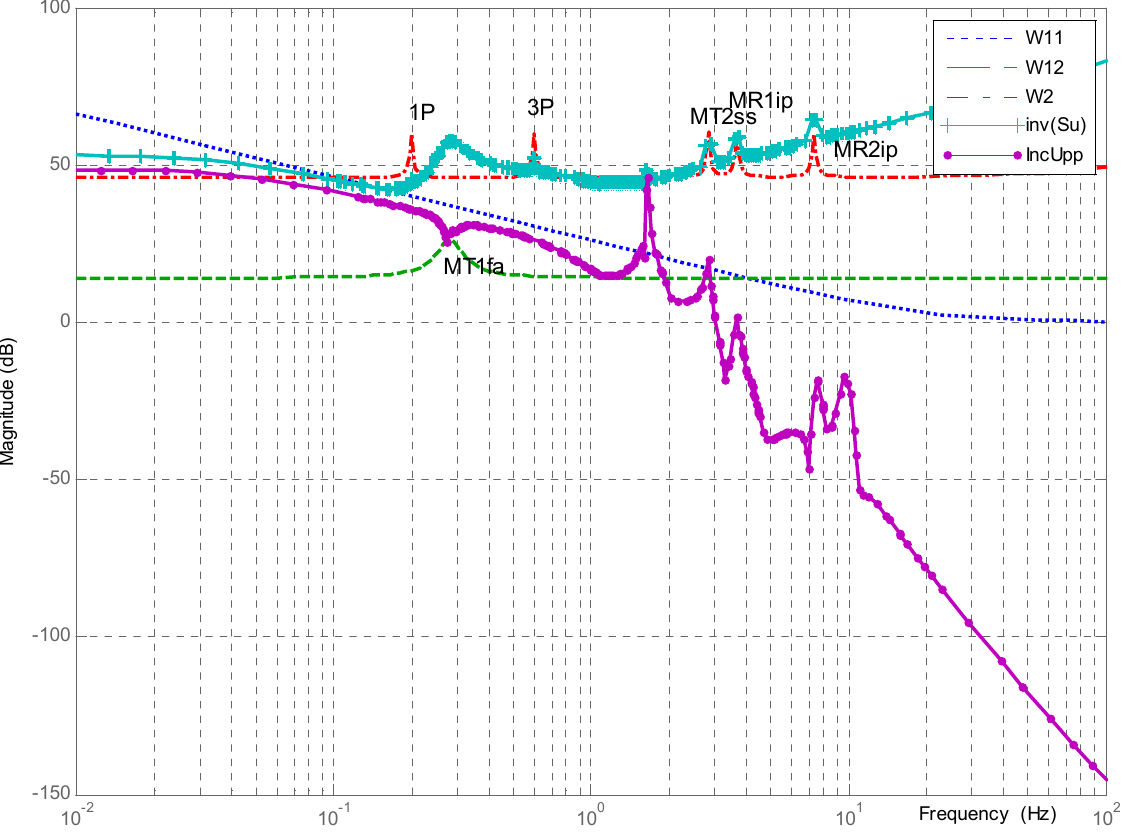
pitch controller ∞